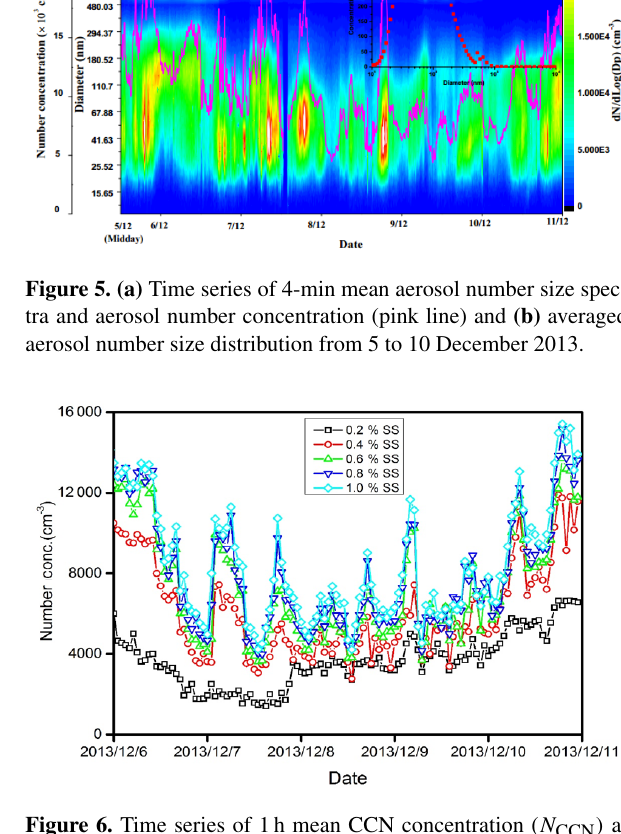
Figure 6. Time series of 1h mean CCN concentration ( N CCN ) at supersaturations (SS) of 0.2–1.0% from 6 to 10 December 2013.